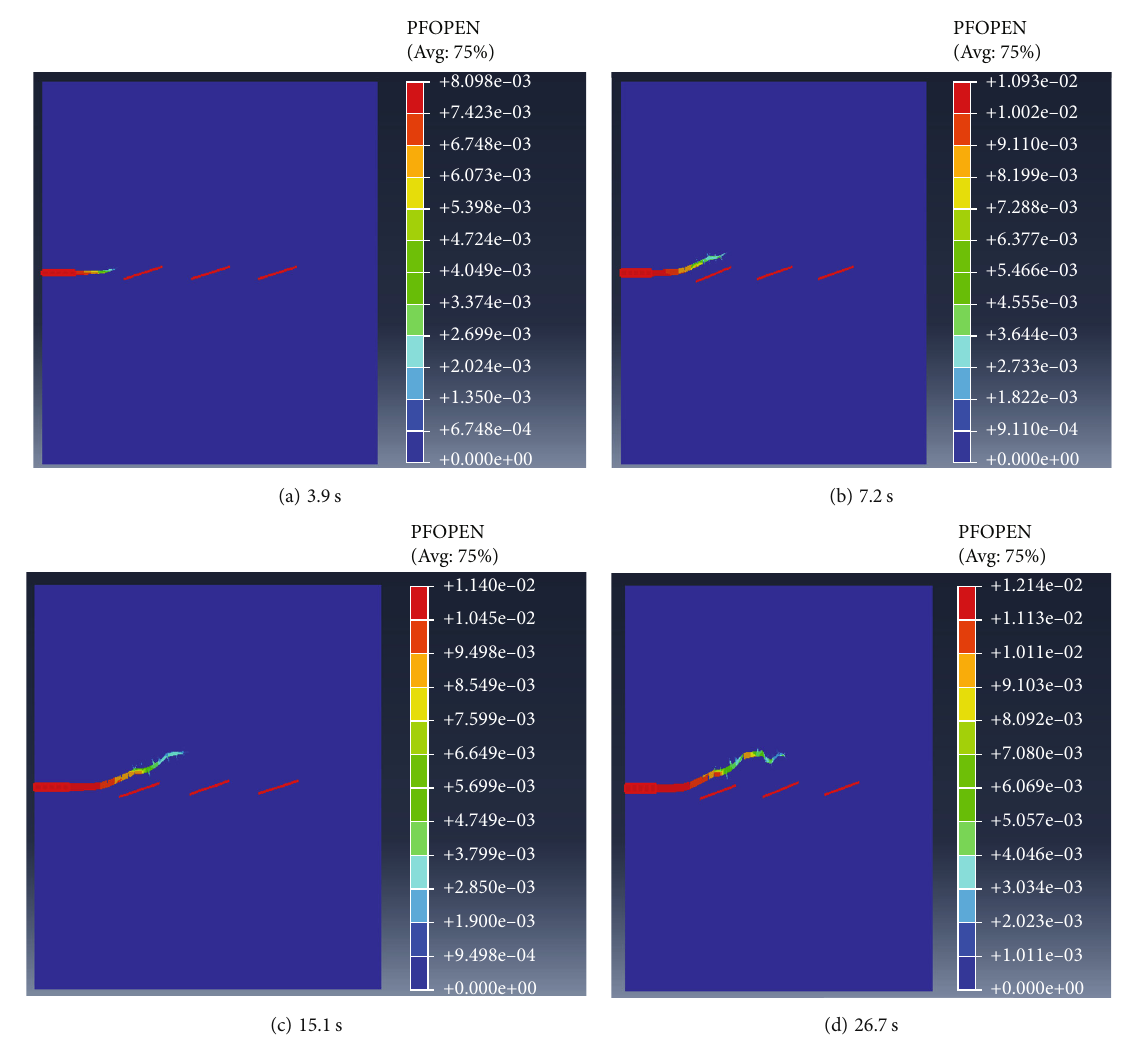
Figure 11: HF propagation at the NF approaching angle of 30 ° and stress anisotropy coe ffi cient of 0.2.